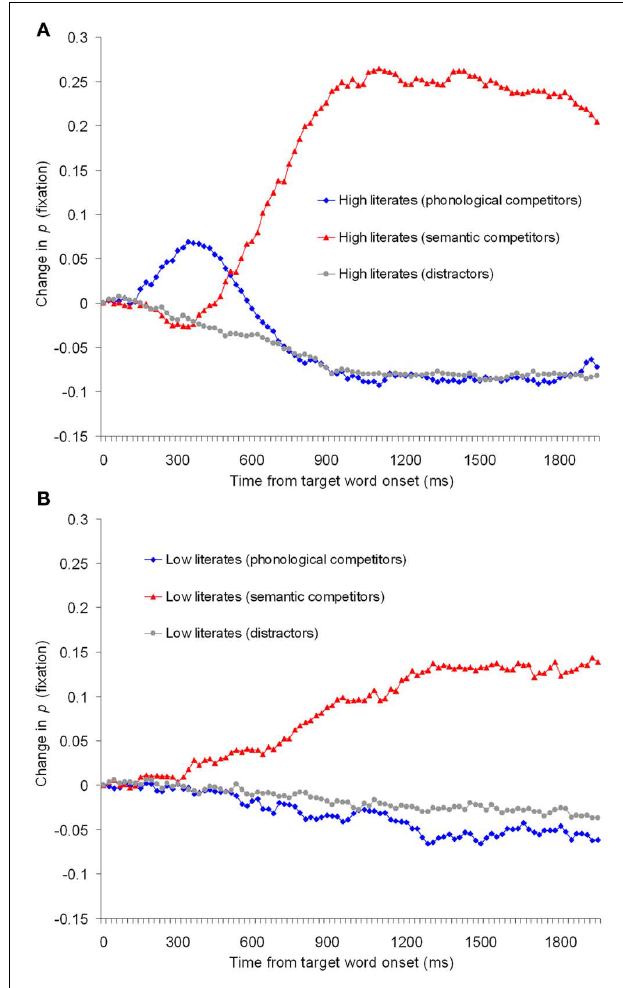
FIGURE 2 | Change in fixation proportions in Experiment 1 for (A) high literates and (B) low